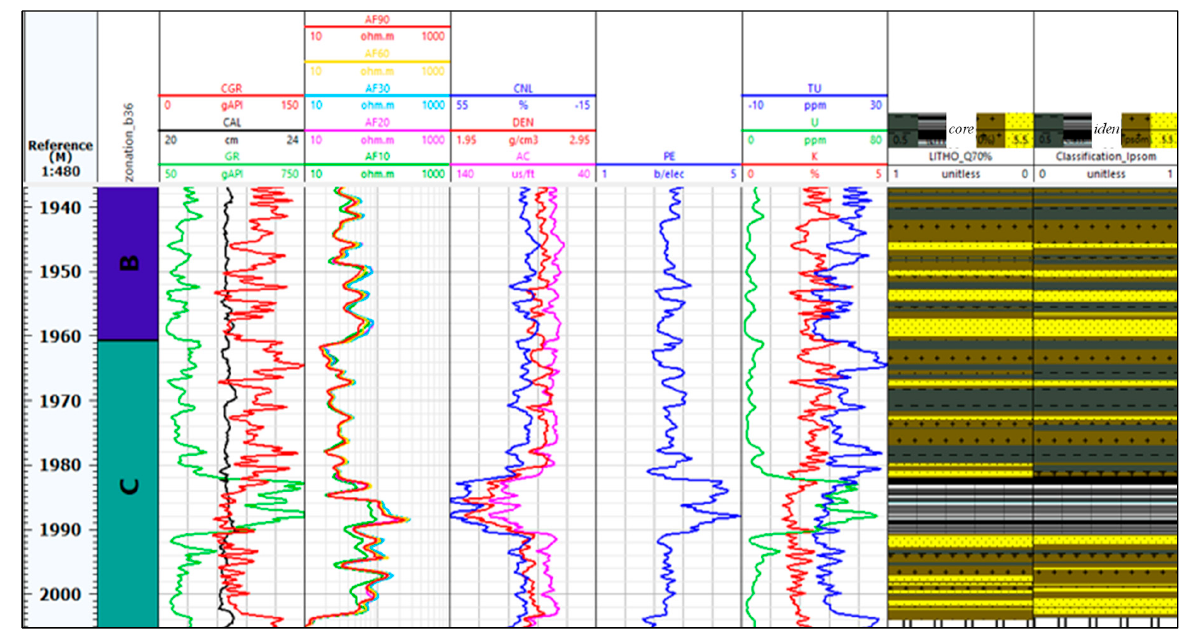
Figure 10. Log interpretation diagram for lithology identi fi cation in Well J2 of Applied Well.